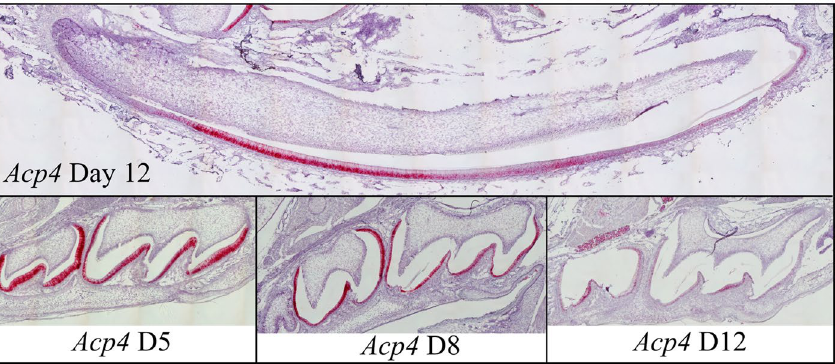
Figure 3. In situ Hybridization of Acp4 in Mouse Incisor and Molars. Upper panel: sagittal section of a mouse hemimandible on postnatal day 12 (D12) showing the continuously growing mandibular incisor where enamel formation progressively advances from basal (left) to incisal (right). Acp4 mRNA is strongly positive in incisor secretory ameloblasts, detectable at lower levels in the incisor maturation ameloblasts, and negative for odontoblasts and any other tissues on the section. Lower panel: at D5 maxillary first and second molars are in the secretory stage of amelogenesis. While most ameloblasts show strong positive signal, those at enamel-free area are negative for Acp4 . In D8 and D12 maxillary first molars, Acp4 mRNA shows reduced, but detectable expression in post-secretory and maturation